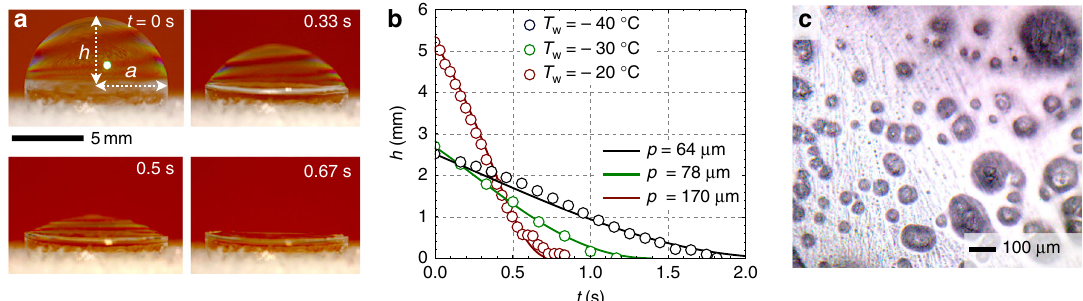
Fig. 6 Collapse of the liquid dome of partially frozen bubbles. a The sudden collapse of the liquid roof of a partially frozen Ω = 500- μ L bubble. Time zero corresponds to the beginning of dome collapse, which was completed in ~1 s. Conditions were T w = − 20 °C, T ∞ = 24.6 °C, and RH = 58.8%. b The height of the liquid dome ( h ) against time for different substrate temperatures, for Ω = 500- μ L bubbles. Solid lines correspond to the theoretical drainage model provided by Eq. 10, for the best- fi t values of p shown in the legend. c Microscopy revealed discontinuities on the frozen portion of the bubble (~10 – 100 μ m),